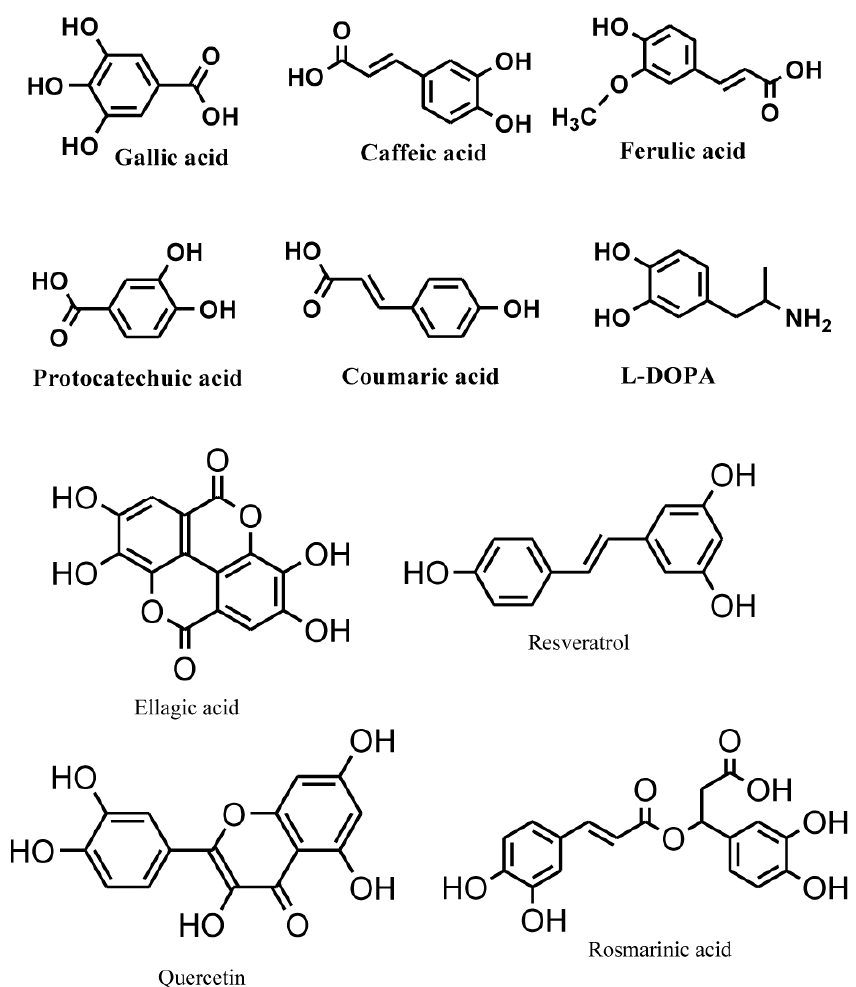
Figure 1. Common phenolic compounds in plants comprise an aromatic ring, bear one or more hydroxyl substituents and range from simple phenolic molecules to highly polymerized compounds (modified from Velderrain-Rodríguez et al., 2014) [2].